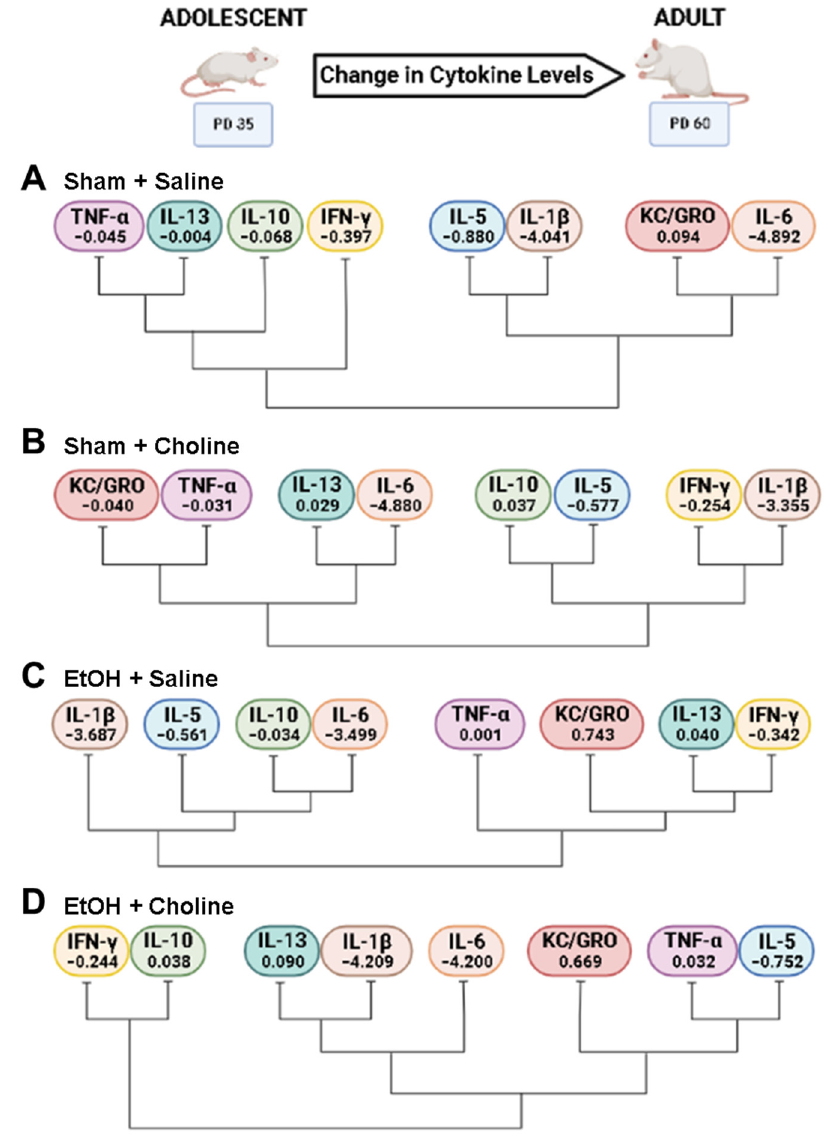
Figure 7. Clustering of cytokines across development in each treatment group. Differential clustering of cytokine changes across development are depicted in the treatment groups: ( A ) Sham + Saline, ( B ) Sham + Choline, ( C ) EtOH + Saline, ( D ) EtOH + Choline. The mean difference score for each cytokine within each group is depicted with each cytokine symbol. Negative numbers represent decrease in cytokine levels from adolescent to adulthood, whereas positive numbers show an increase. EtOH: Ethanol. Created using BioRender.com.